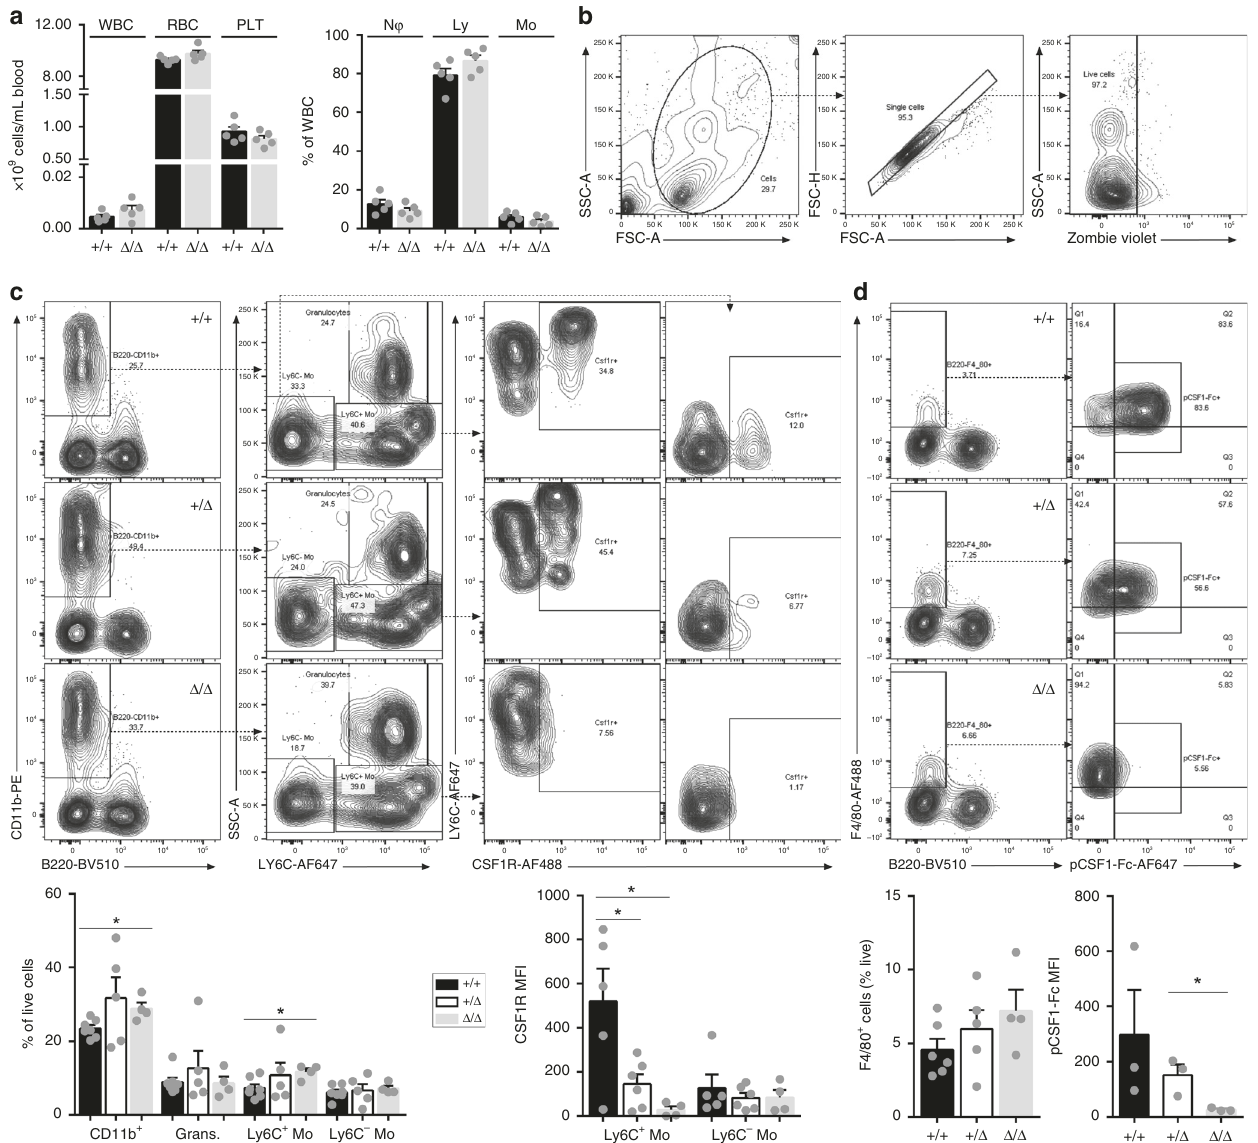
Fig. 3 FIRE deletion reduced functional CSF1R expression in blood. a Cell populations in whole blood of 11 – 13-week-old Csf1r Δ FIRE/ Δ FIRE mice ( Δ / Δ ) and controls ( + / + ) were quanti fi ed using an automated hematology analyzer. n = 5 mice per genotype. WBC white blood cells, RBC red blood cells, PLT platelets, N φ neutrophils, Ly lymphocytes, Mo monocytes. b Whole EDTA-blood from 11 to 13-week-old mice was analyzed by fl ow cytometry. Plots show the representative gating strategy to identify live single cells for subsequent analysis. c Myeloid cells were identi fi ed as CD11b + B220 − (Panel 1) then separated by LY6C and SSC to identify granulocytes (LY6C + SSC hi , panel 2). The LY6C + and LY6C lo monocyte populations were then analyzed for CSF1R expression (Panels 3 and 4, respectively). n = 7 + / + , 5 + / Δ , and 4 Δ / Δ from four experiments. For % of live cells P = 0.012 (*CD11b + ) and 0.019 (*LY6C + Mo). For median fl uorescence intensity (MFI) of CSF1R P = 0.027 (* + / + vs. + / Δ ), and 0.022 (* + / + vs. Δ / Δ ). Grans. granulocytes, Mo monocyte. d F4/ 80 + B220 − myeloid cells were analyzed for binding of CSF1 (pCSF1-Fc AF647 ) 11 . n = 3 mice per genotype from four experiments. P = 0.033 (*). All source data are provided within a Source Data excel fi le. Graphs show mean + SEM and P values were determined by two-tailed t -tests Macrophage populations in Csf1r Δ FIRE/ Δ FIRE mice . We per- reduction in the number of cells expressing LY6C, KIT, or FLT3 (Supplementary Fig. 3e). In view of the apparent loss of CSF1R formed fl ow cytometry and/or immunohistochemistry analyses protein, we examined whether BM from mutant mice is responsive to on major organs as shown in Fig. 4, Supplementary Figs. 4 and 5. CSF1. BM-derived macrophages (BMDM) are generated from Liver macrophages (Kupffer cells, KC) are CSF1R-dependent 4,6 , CSF1-responsive 27 , and the main site of clearance of labeled Csf1r Δ FIRE/ Δ FIRE BM, but with greatly reduced yield compared to controls (Supplementary Fig. 3f). The macrophages derived from CSF1 11 . The number, location, or morphology of KC and the liver-to-body weight ratio of Csf1r Δ FIRE/ Δ FIRE mice are similar to Csf1r Δ FIRE/ Δ FIRE BM still express F4/80 and CD11b but have lower levels of surface CSF1R detected with pCSF1-Fc AF647 relative to littermate controls (Supplementary Fig. 4a, b). Flow cytometry controls (Supplementary Fig. 3g). Hence, the production/survival of analysis con fi rmed the unchanged numbers of KC and dendritic these few BMDM relies on some mechanism that compensates for cell subsets (cDC2 as de fi ned previously 11 ) (Fig. 4a) and retention the absence of FIRE. of KC-speci fi c markers such as TIM4 (Supplementary Fig. 4c). NATURE COMMUNICATIONS| (2019) 10:3215 |https://doi.org/10.1038/s41467-019-11053-8|www.nature.com/naturecommunications